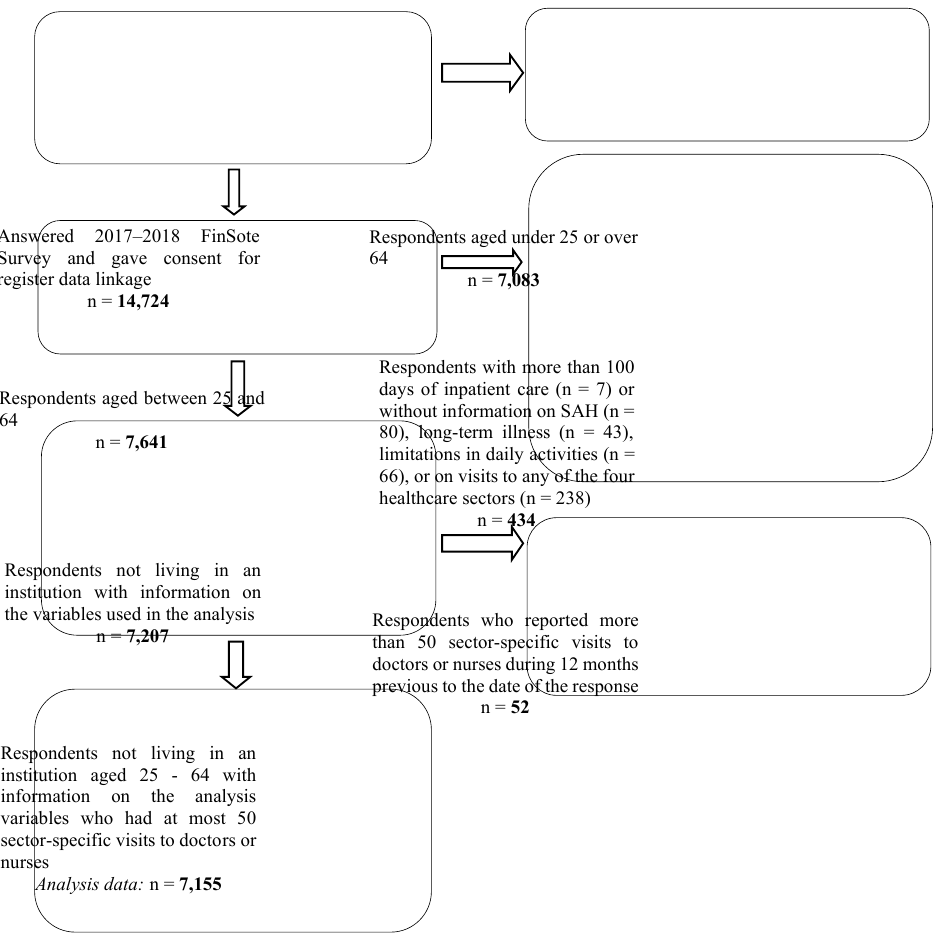
Figure 1: Flow chart for the final dataset used in the